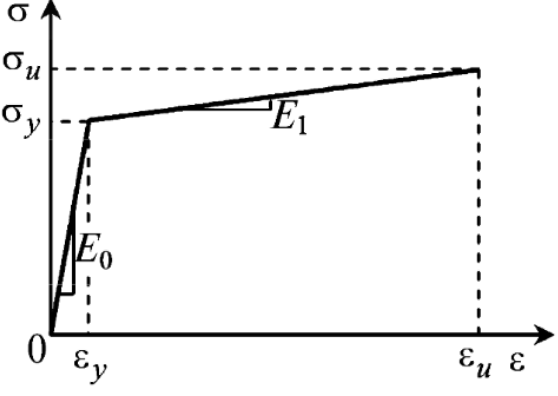
E 0 – modulus of elasticity of steel; E 1 – tangent modulus in the area of elastoplastic deformation; σ y and ε y – stress and defor- mation of the transition point to the section of elastoplastic deformation; σ u and ε u – stress and strain corresponding to the ultimate strength of the steel pipe material. Fig. 3. Diagram of uniaxial tension of steel during deformation in the annular